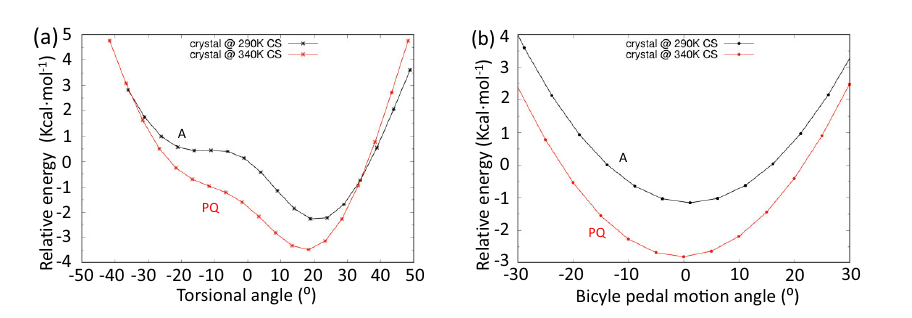
Fig. 7 Potential energy surface dependence of CAR with torsion and bicycle pedal motions. a Torsional angle potential energy pro fi les of the CAR molecule inside the crystal structure at 290 K (A form) and of that at 340 K (PQ form). b Potential energy pro fi les of the CAR molecule inside the crystal structure at 290 K (A form) and of that at 340 K (PQ form) alongside the bicycle pedal motion distortion. Calculations were carried out with the QM/MM ONIOM model on the cluster of CAR molecules, B3LYP/6-31G* level with electronic embedding for the central molecule, Dreding force fi eld, and charges determined with the Qeq approach for the